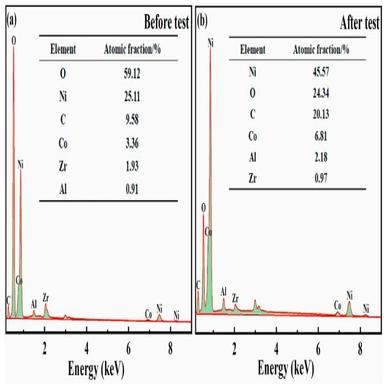
Elemental content of (a) 1 wt % LZO@NCAL samples before test; (b) 1 wt % LZO@NCAL anode after test.